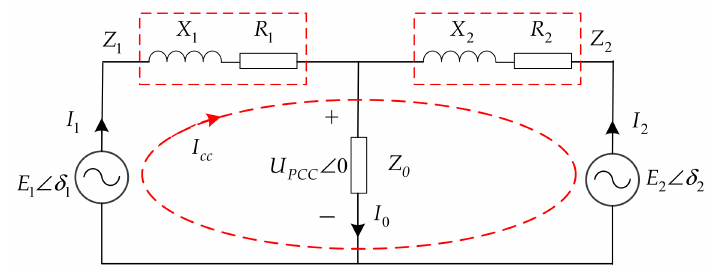
Figure 2. Equivalent circuit diagram of two parallel